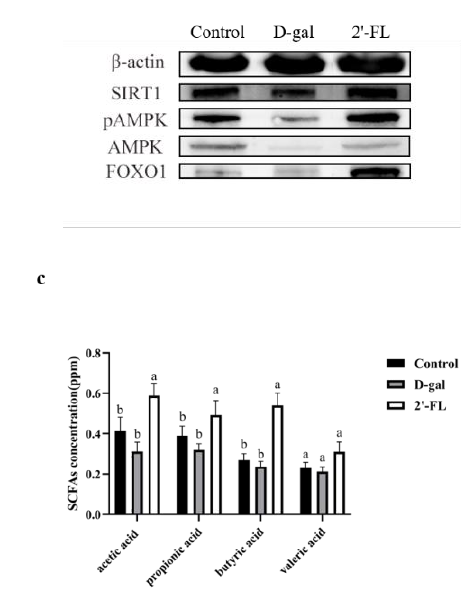
Figure 4. Effects of 2′− FL on longevity pathways. ( a ) Gene and protein expressions of the AMPK/SIRT1/FOXO1 pathway in the colon. ( b ) Expression of G-protein-coupled receptors (GPRs) in the colon at the gene level. ( c ) Content of short-chain fatty acids (SCFAs) in the colon contents. Letters a and b indicated significant differences between groups ( p <